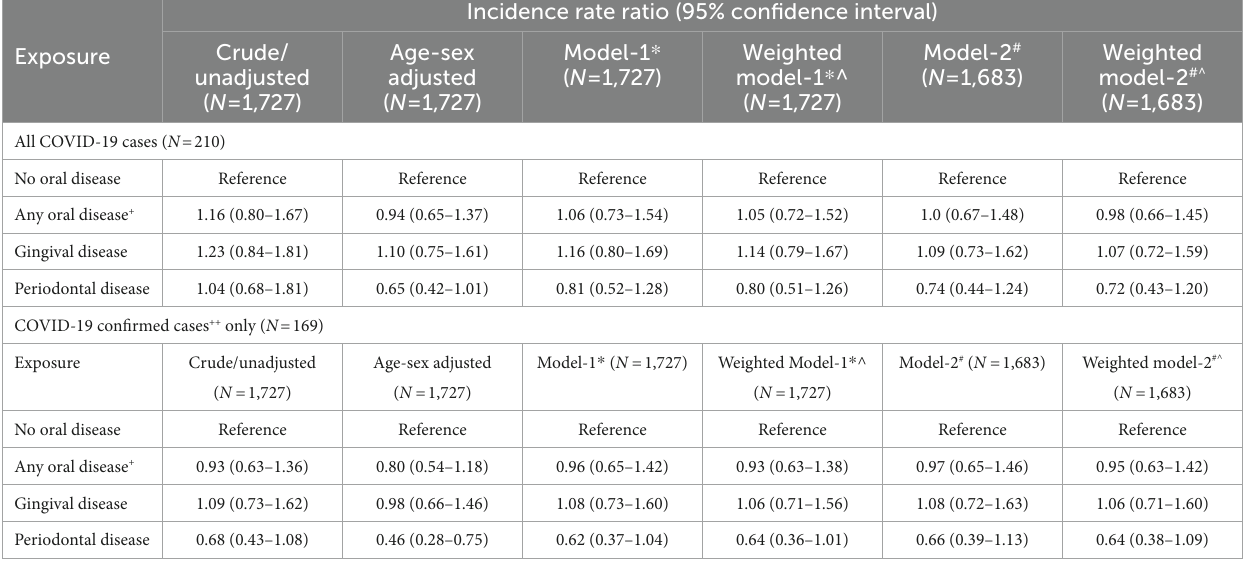
TABLE 4 Unadjusted and adjusted incidence rate ratio for the association of COVID-19 incidence with baseline oral disease of study participants aged ≥ 20